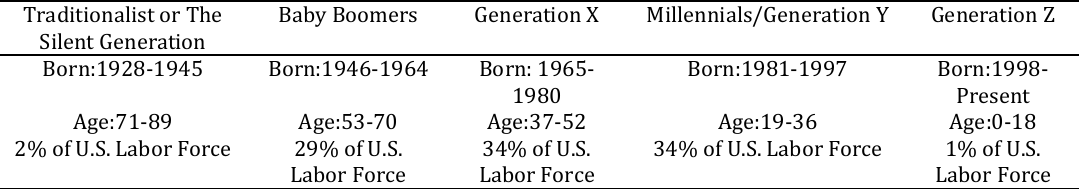
Table 1: Five active generations in the American workforce. Adapted from “Satisfy the needs of your multi-generational workforce. Employee Benefits and Wellness Excellence Essentials” Traditionalist or